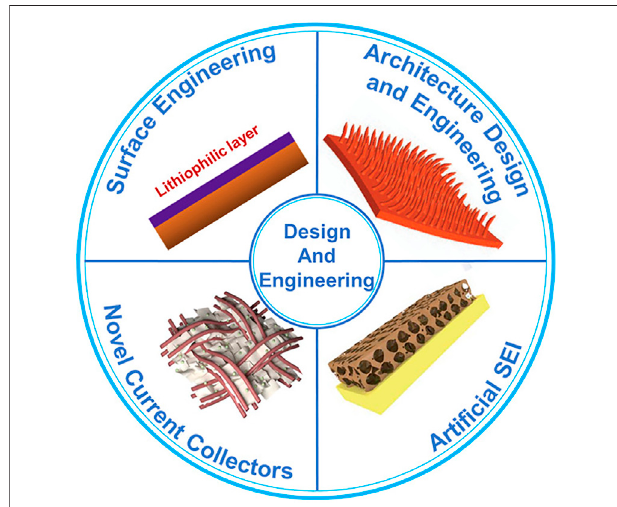
FIGURE 1 | Strategies for the design and engineering of the anode current collector. Reproduced from Yang et al. (2015), Deng et al. (2018), Wu et al. (2021b) with permission from the Springer Nature, Elsevier, Royal Society of Chemistry.